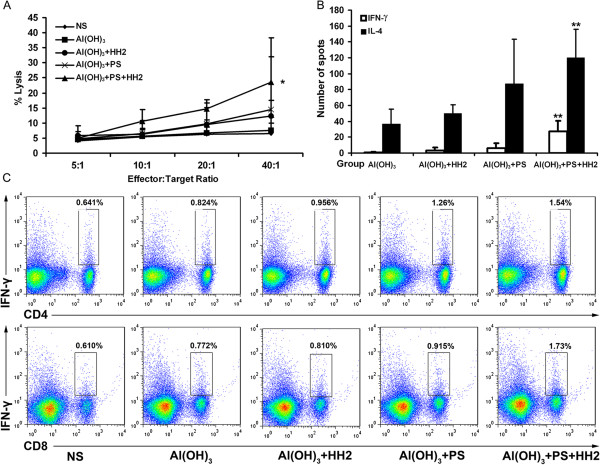
NAPH vaccination elicits robust NY-ESO-1-specific cellular response in vitro. A, The cytotoxicity of splenocytes against NY-ESO-1-B16 cells was examined in a 4-h 51Cr-release assay. Points, mean of triplicate samples; bars, SD. B, IL-4/IFN-γ ELISPOT responses were performed at one week post-immunization (n = 3, three replicates). C, Intracellular staining of IFN-γ in CD4+ and CD8+ T cells. Similar results were obtained from three independent experiments (*P < 0.05; ** P < 0.005).